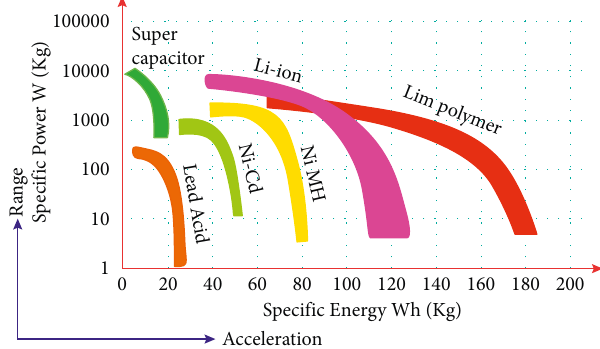
Figure 9: Relation between specific energy and specific power of various storage systems used in